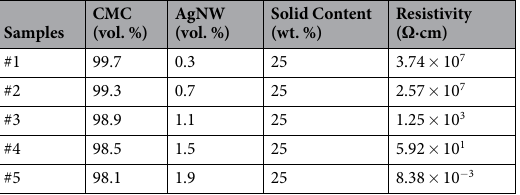
Table 1. Prepared AgNW/CMC composite with different concentrations and their resistivity.